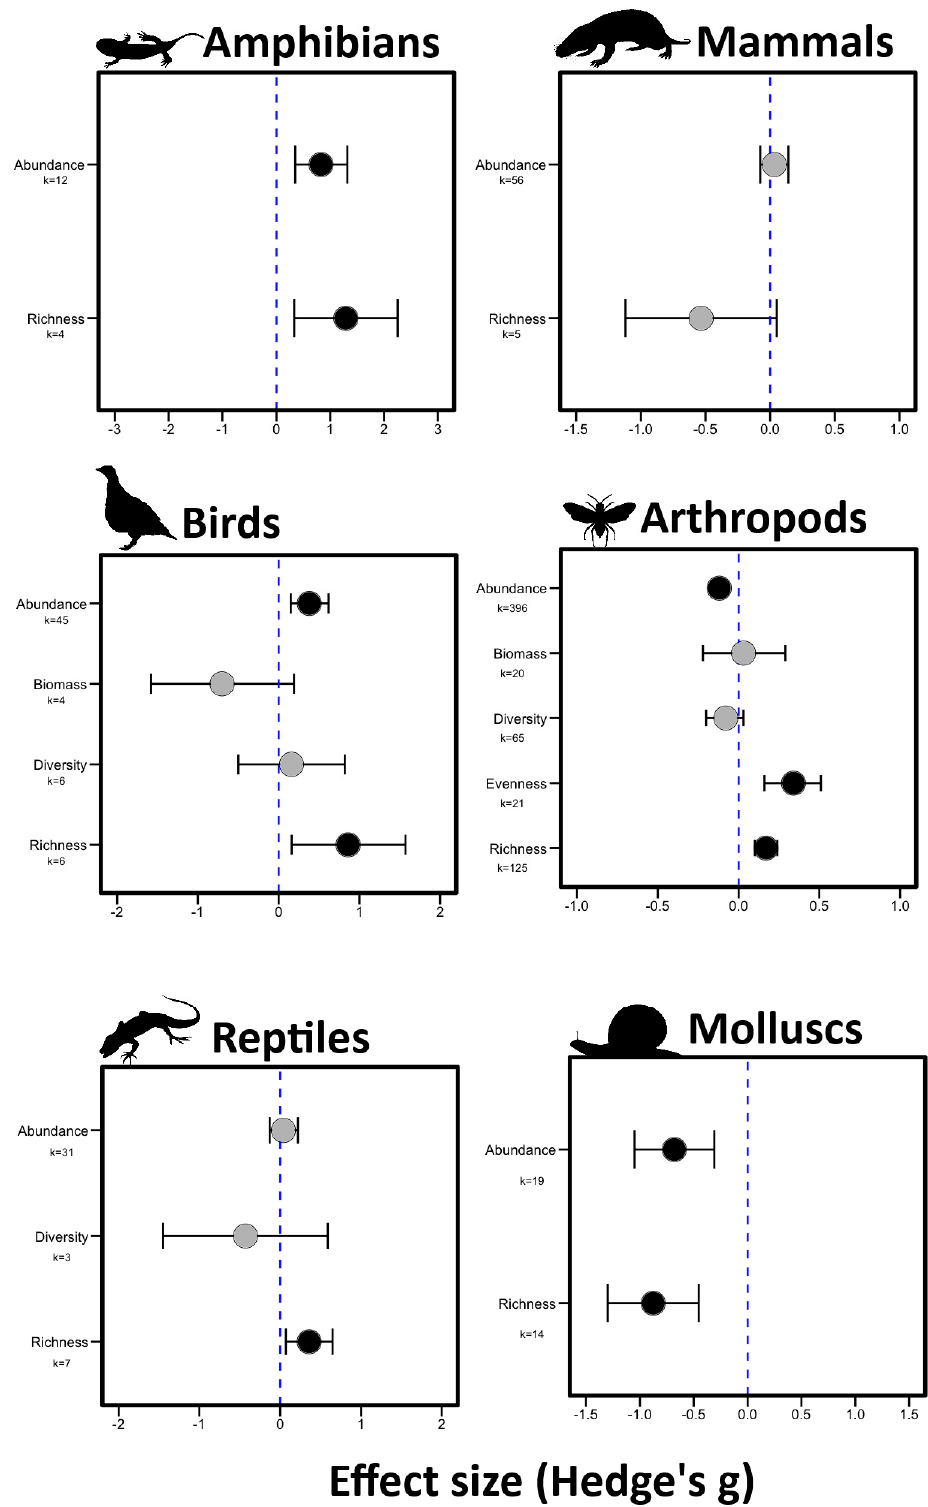
Figure 2. Effect of fire on abundance, biomass, diversity, evenness, and richness of aboveground faunal groups. The x-axis shows overall effect size (Hedges’ g). k is the number of observations included in each analysis. Circles denote the hedges’g value and lines denote the 95% confidence intervals (CI) for each Hedges’ g value. Black circles represent significant effects whist grey circles show no significant effects the Hedges’ g value.